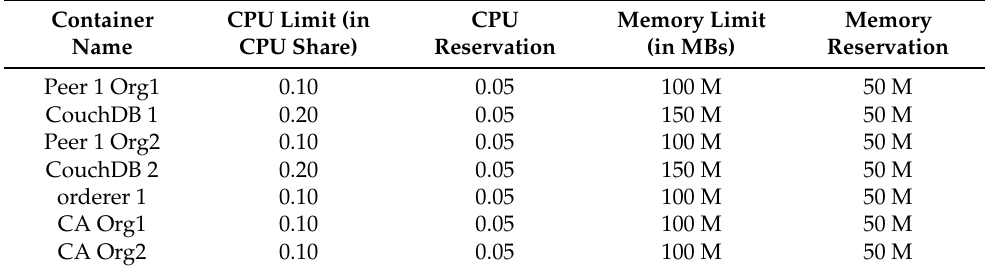
Table 3. Blockchain network resource